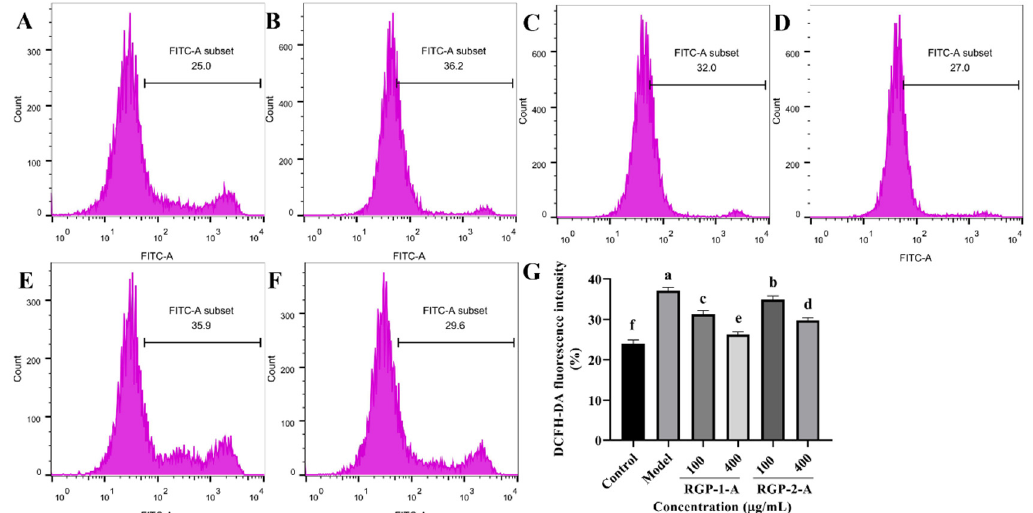
Figure 4. Effect of RGP pretreatment on ROS levels in LPS-induced IPEC-J2 cells. ( A ): Control group; ( B ): model group; ( C ): RGP-1-A low concentration; ( D ): RGP-1-A high concentration; ( E ): RGP-2-A low concentration; ( F ): RGP-2-A high concentration; ( G ):Quantitative analysis of ROS content in cells. RGP-1-A: decolorized pure polysaccharides of RGP obtained using AB-8 macroporous resin; RGP-2-A: decolorized pure polysaccharides of RGP obtained using H 2 O 2 . On the bar graphs, different lowercase le tt ers signify a signi fi cant di ff erence ( p < 0.05).